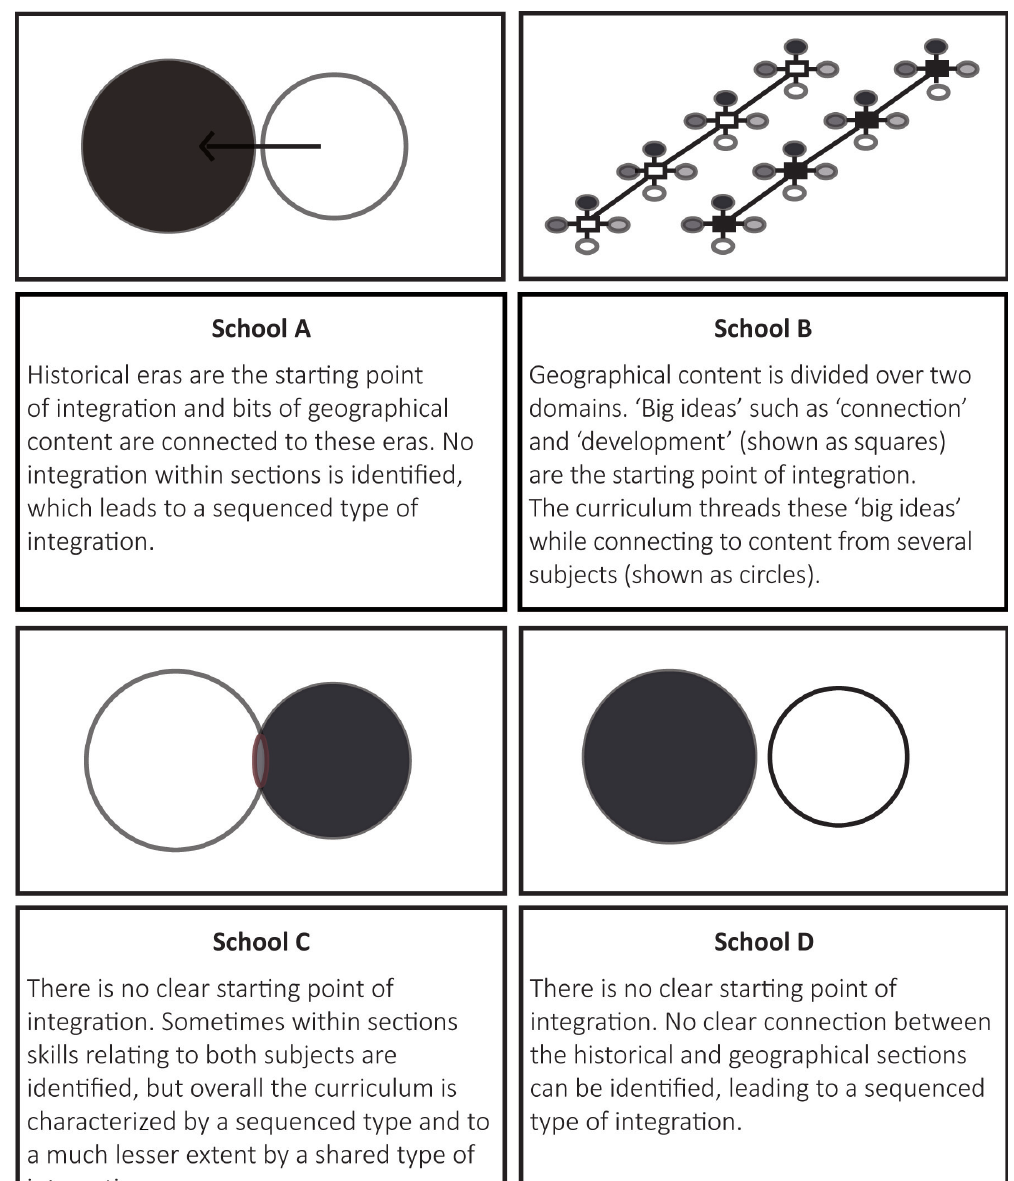
Figure 3: Visualization of the ‘human and society’ curricula at Schools A, B, C and D, based on Fogarty (1991) Note: The figures show the way in which geographical (white circles) and historical (black circles) content are integrated. In the case of Schools A, C and D, the size of the circles roughly represents the share of geographical and historical content within the